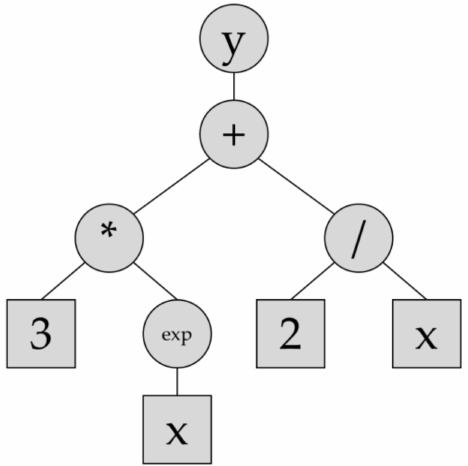
Figure 2. An example of an expression tree representing the function y = 3e x +